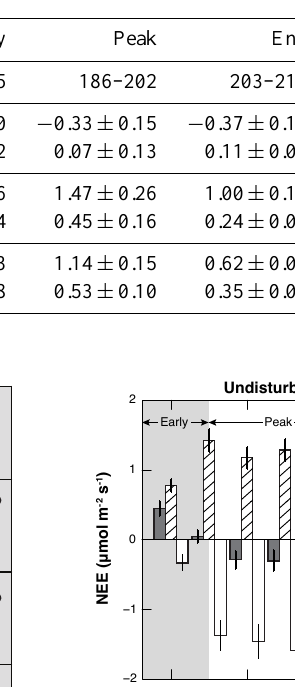
Table 2. Summary of measurements (mean ± SE) from the portable chamber system (in µmolm − 2 s − 1 ).